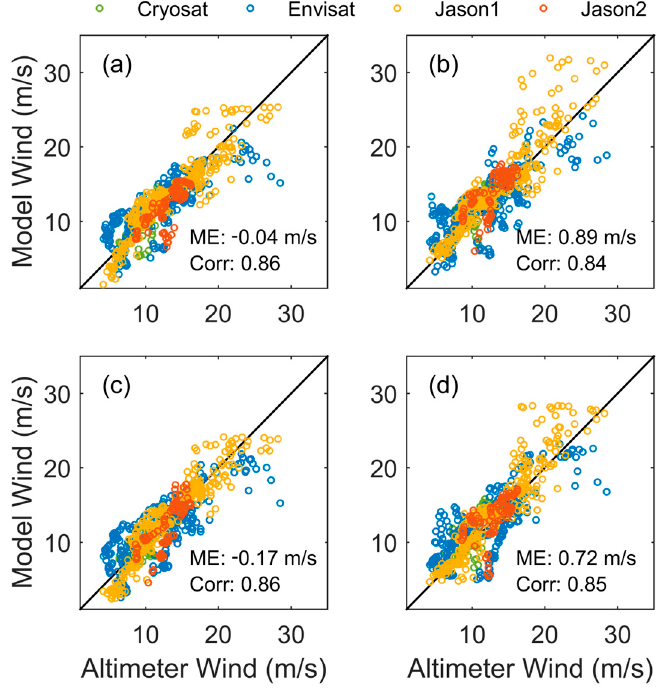
Figure 7. Typhoon Megi. Comparison of altimeter-observed 10 m winds with model results from experiments ( a ) R0, ( b ) R1, ( c ) R2, and ( d ) R3. See Table 1 for details of the different numerical experiments.